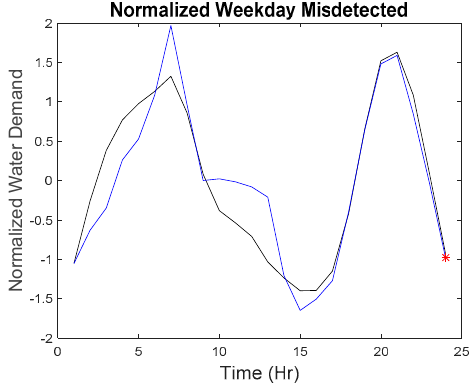
Figure 23. Shape of series with fifth missed detected anomaly.